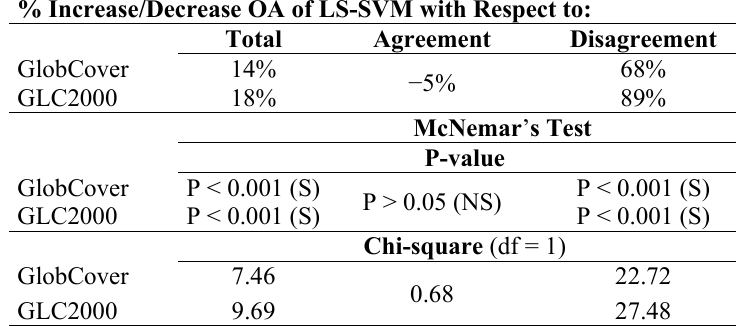
Table 4. Summary table for validation data excluding points of low spatial homogeneity; the top part of the table shows the percentage of increase/decrease of overall accuracy (OA) for LS-SVM with respect to GlobCover and GLC2000. The bottom part of the